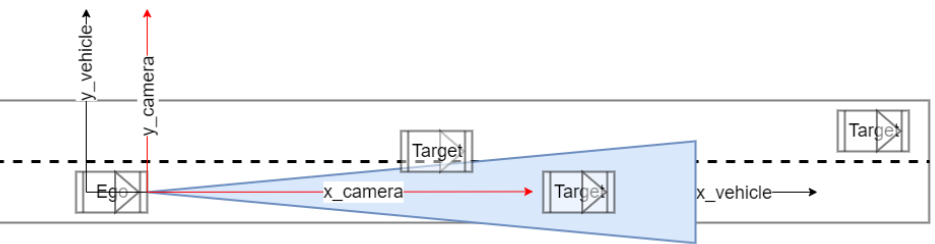
Figure 4. Mono camera-based multi-target tracking system.